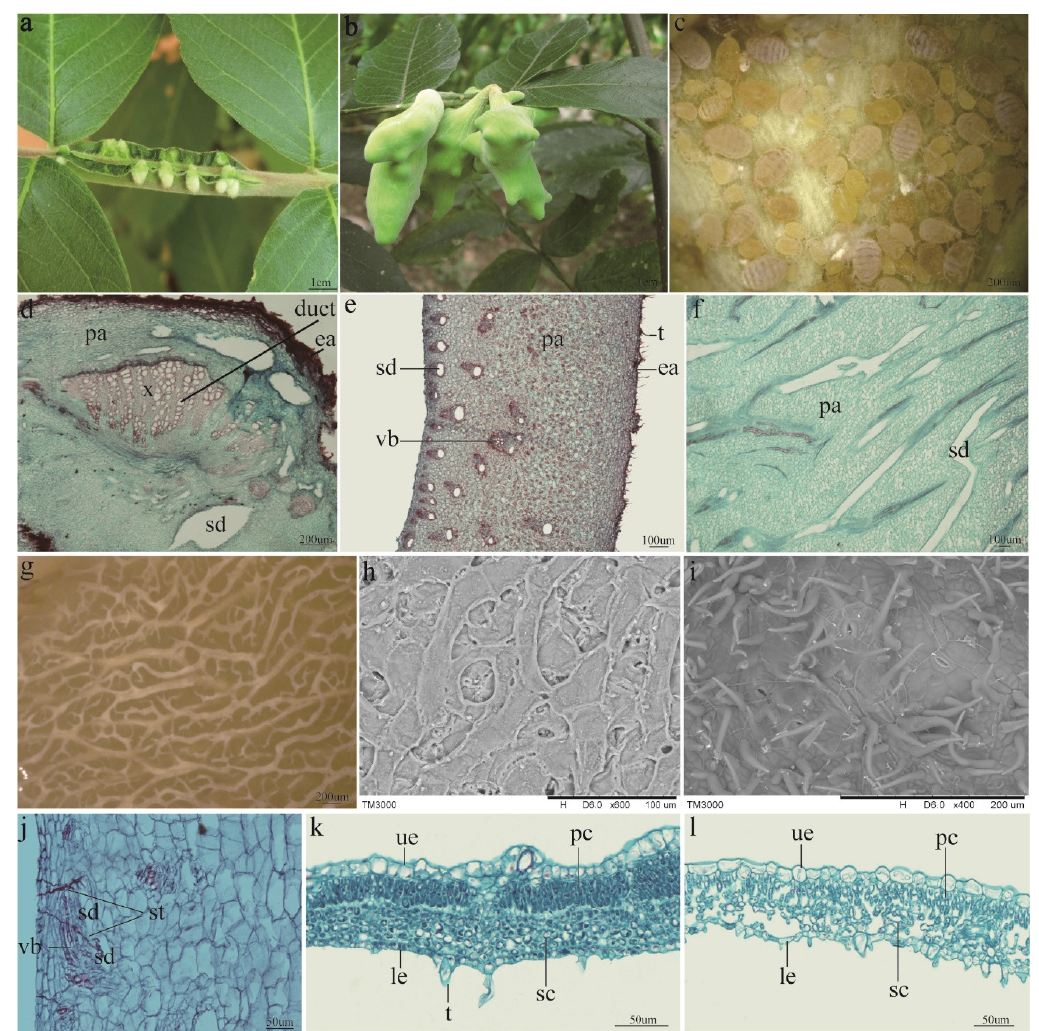
Figure 1. Localization, morphology, and anatomical structure of the horned gall. ( a ) Young horned galls clustered on rachis wings. ( b ) Mature galls connected with rachis leaf wing via a specialized stalk. ( c ) Aphids feeding on inner wall. ( d ) Cross-section of the stalk. Many ducts are present in the expanded xylem. ( e ) Crosscutting of the gall wall. The wall comprises parenchyma cells and contains many vascular bundles that are joined to the schizogenous ducts. ( f ) Plane surface of the horned gall; long schizogenous ducts are present. ( g ) The inner surface of the horned gall treated by NaOH. Vast, branched schizogenous ducts are present in the inner wall. ( h ) A scanning electron microscope (SEM) image of the inner surface. The inner wall was rough and characterized by holes. ( i ) The outer surface of the horned gall in the SEM image. Stoma and tomentum are present in the outer wall. ( j ) The stylophores of the aphids. Stylophores gathered in the vascular bundle of the horned gall. ( k ) The cross-section of the young R. chinensis leaf. The palisade and spongy cells are closely arranged. ( l ) The cross-section of the mature R. chinensis leaf. The cells, particularly the spongy tissues, are loose and porous. ea = epidermis-air, x = xylem, pa = parenchyma, sd = schizogenous duct, vb = vascular bundle, t = tomentum, st = stylophore, el = epidermis-lumen, pc = palisade cell, sc = spongy cell, le = lower epithelial cell, ue = upper epithelial